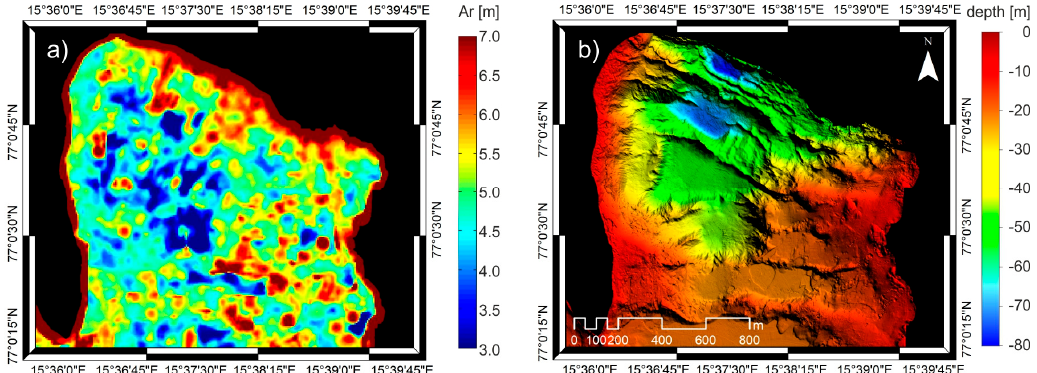
Figure 8. Detailed maps of the bottom of Isbjørnhamna and Hansbukta Bays in the Hornsund Fjord, which compare the autocorrelation length (a parameter describing the terrain roughness with a spatial scale in the range of 1–49 m, for DEM with a step of d = 0.5 m in the moving window with a side length of 70 m and 90% overlapping) with the bathymetry of the area; ( a ) the autocorrelation length and ( b ) seafloor morphology of the same area with basins filled with sediments and recessional